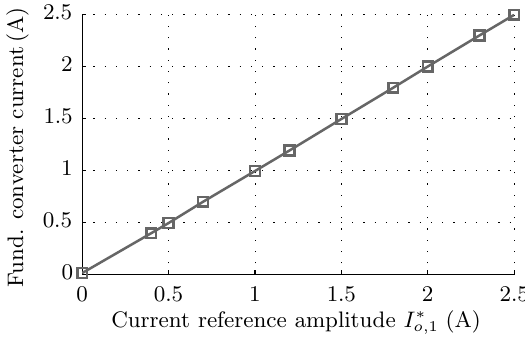
Figure 13. Measured fundamental current amplitude (through FFT) as a function of its reference I ∗